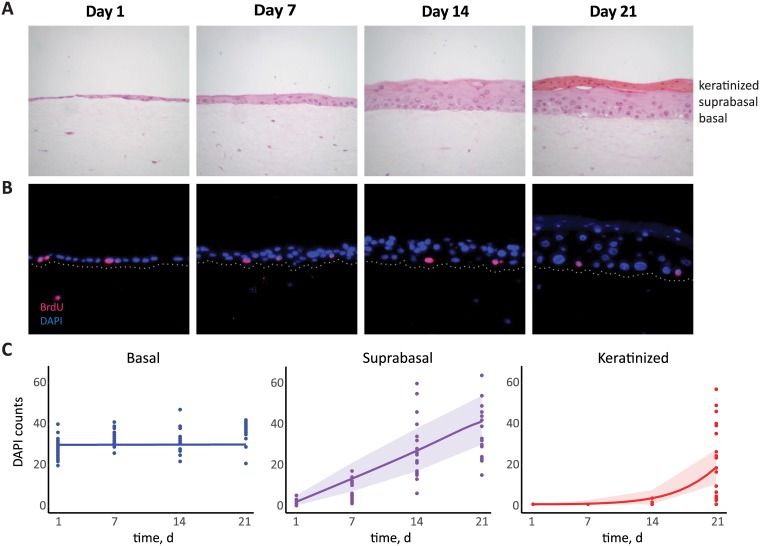
Epithelial cell growth in 3D raft cultures.A) NIKS grown from a single layer over a period of three weeks. Dark pink layer in week 3 consist of cornified cells that accumulate on the surface. B) Immunoflourescence staining: DAPI (blue) is nuclear staining for cell counting and BrdU (pink) is for identifying cells undergoing division; white dots are added to delineate basal lines. C) Data of NIKS growth over time with model fitting. Shading corresponds to 95% prediction interval, assuming the data follows a Poisson distribution.